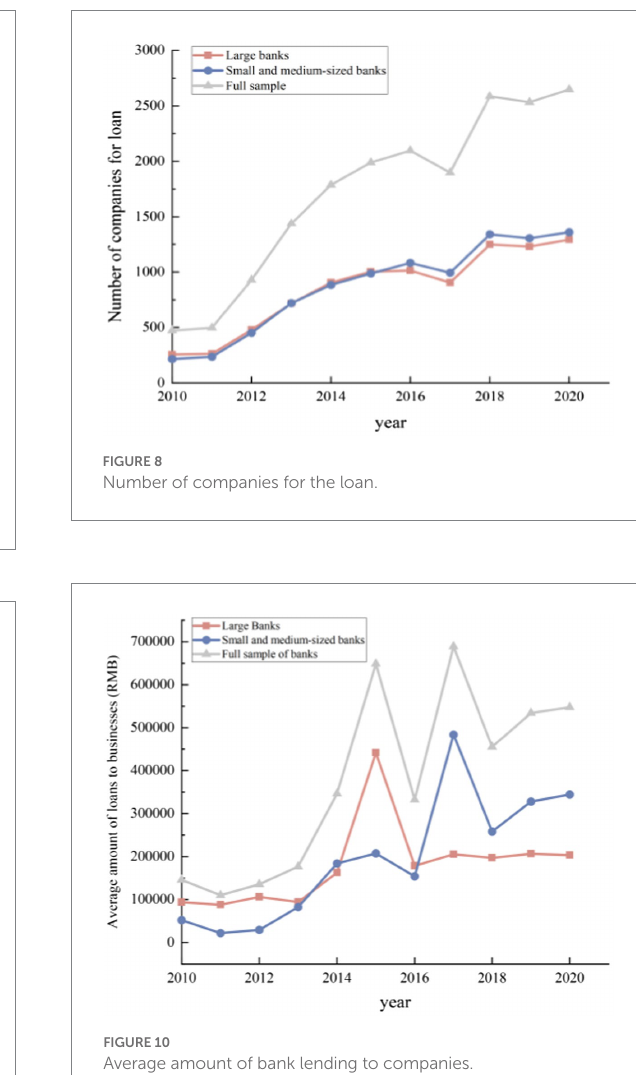
FIGURE 9 Total loans of banks.